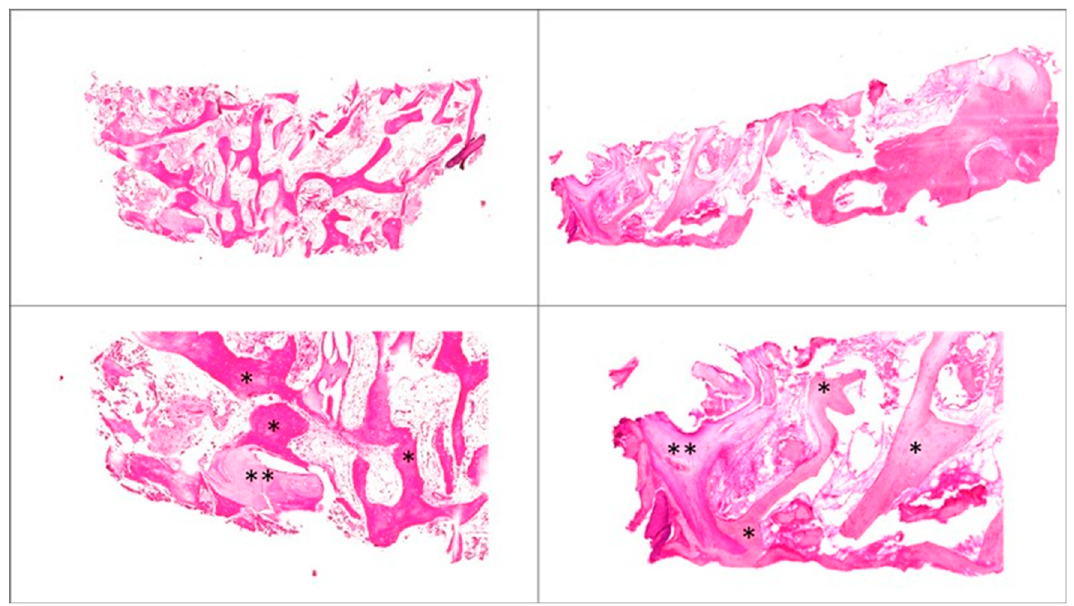
Figure 5. Hematoxylin-eosin staining, histology. Top : 3.5 × magnification. Left , an ABB case. Right , an EDEB case. Bottom : detail, 10 × magnification. Symbols: *, newly formed bone; **, residual biomaterial.